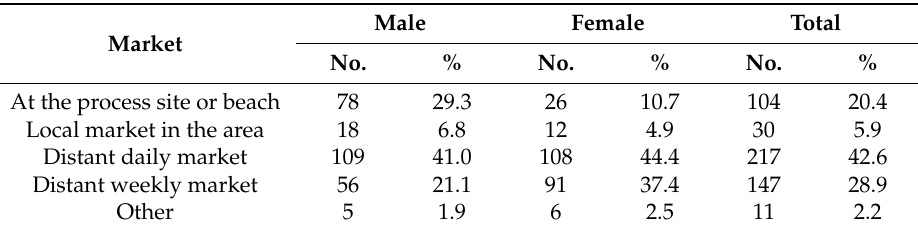
Table 4. Markets for processed small pelagic fish.